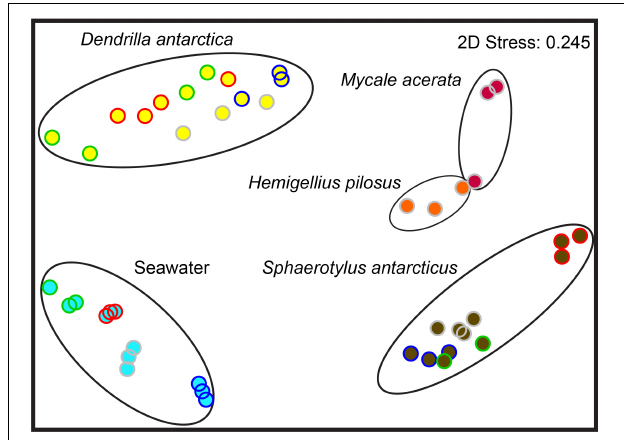
FIGURE 2 | Non-metric multi-dimensional scaling plot of microbial community structure from replicate individuals of Dendrilla antarctica (yellow), Sphaerotylus antarcticus (brown) , Mycale acerata (red), Hemigellius pilosus (orange) and surrounding seawater (light blue) from O’Higgins (green circles), Half Moon Island (red circles), Deception Island (gray circles) and Rothera (blue circles). Stress value for two-dimensional ordination is shown.